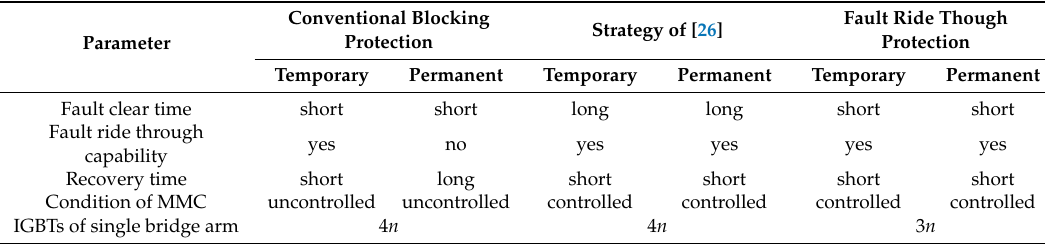
Figure 9. The simulation results of the MMC-HVDC: ( a ) DC voltage and current, grid currents; ( b ) active and reactive power; ( c ) current and a single SM capacitor voltage of A phase upper bridge arm, and ( d ) the capacitor voltages of the SMs and the sums of the capacitor voltages of six bridge arms. Table 2. Comparison of three strategies.